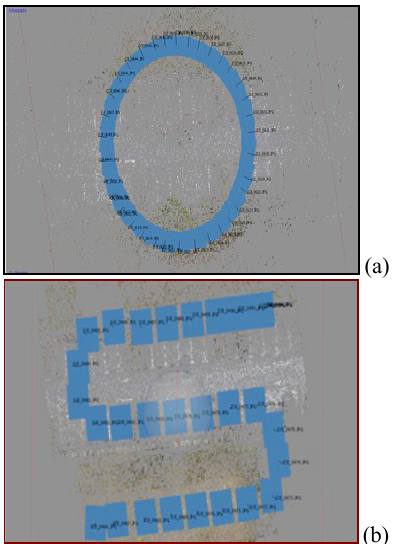
Figure 3. Flight planning; (a) Waypoint technique, (b) POI technique